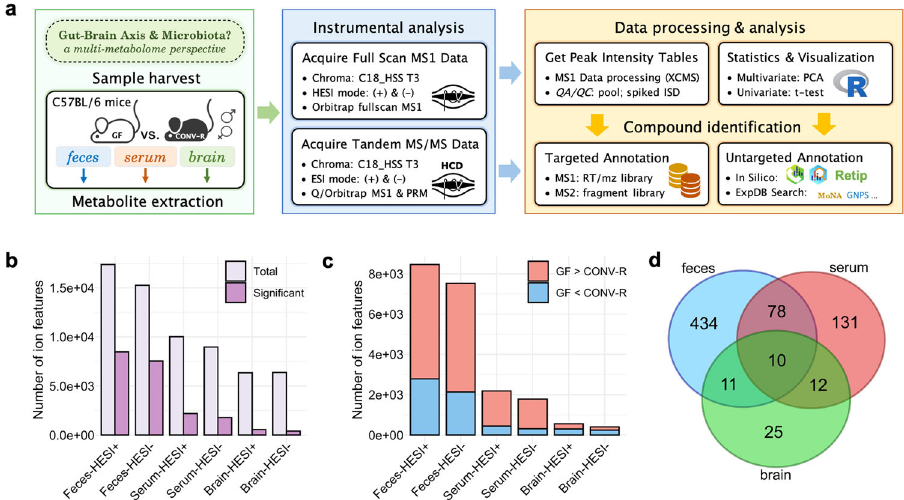
Fig. 1 Overview of experimental approach and multi-metabolomics analyses. a Experimental work fl ow started with sample harvest and metabolite extraction of feces, blood sera, and cerebral cortical brain tissues from 8-week age-matched germ-free (GF, N = 12) and conventionally raised (CONV-R) speci fi c-pathogen-free C57BL/6 mice ( N = 12). A novel high-coverage metabolomics approach was used featuring orbitrap high-resolution mass spectrometry, targeted annotation based on an in-house mass spectral library, untargeted annotation using a streamlined cheminformatic pipeline for de novo structural dereplication, univariate and multivariate statistics, and data visualization. b Number of total and signi fi cant ion features ( p -value < 0.01, fold change ≥ 1.5, two-sided Welch ’ s t- test) detected for feces, blood sera, and cortical brain tissues under HESI positive and negative modes of analysis. c Trend distribution of signi fi cantly altered ion features. d Venn diagram of all identi fi ed metabolites of GF/CONV-R difference among the three sample matrices. Chroma chromatography, HESI heated electrospray ionization, PRM parallel reaction monitoring, QA / QC quality assurance/quality control, ISD internal standard, PCA principal component analysis, RT/mz library retention time and mass-to-charge ratio pair library, ExpDB experimental database, MoNA MassBank of North America, GNPS The Global Natural Product Social Molecular